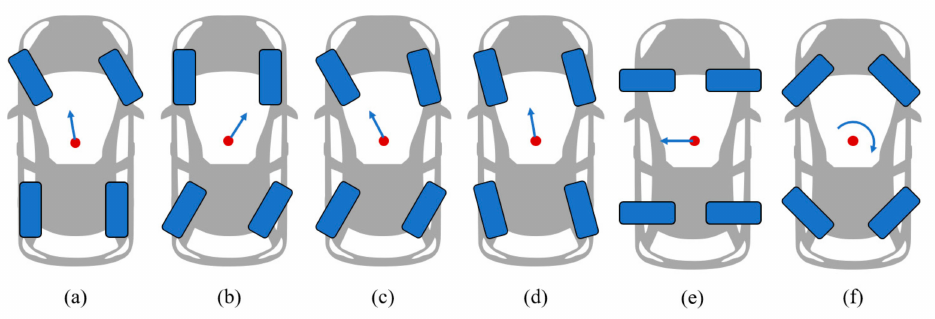
Figure 4. Steering modes of 4WID-4WIS EV: ( a ) FWS; ( b ) RWS; ( c ) 4WS; ( d ) oblique moving; ( e ) crab moving; ( f ) pivot